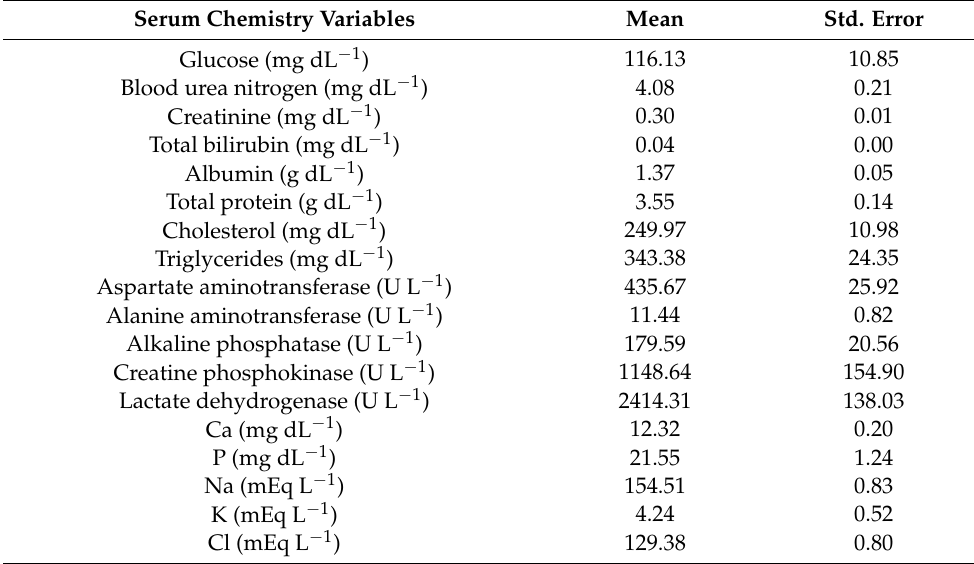
Table 2. Mean and standard error of serum chemistry variables. Serum Chemistry